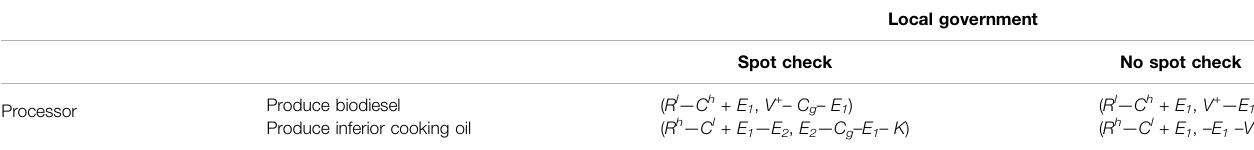
Processor Produce